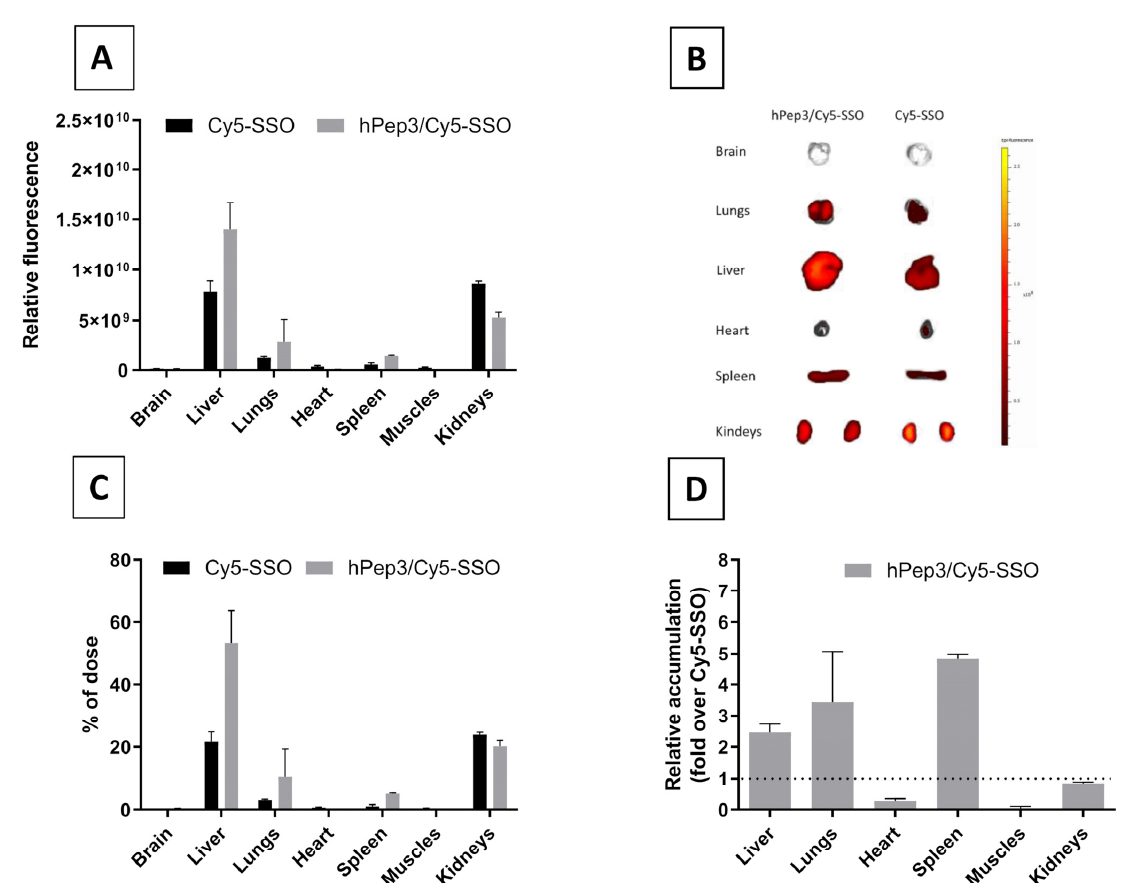
Figure 7. Biodistribution of hPep3/SSO nanoparticle formulation in vivo. ( A ) Biodistribution of hPep3/SSO nanoparticles in mice was evaluated upon intravenous injection of hPep3/Cy5-SSO nanoparticles or naked Cy5-SSO (at 2.5 mg/kg of SSO). 24 h after the injection, the tissues were harvested and the biodistribution evaluated by quantifying the total fluorescence with IVIS in vivo imager. ( B ) Representative IVIS images of the biodistribution of hPep3/Cy5-SSO and naked Cy5-SSO in different organs. ( C ) Percentage of the fluorescence signal from the total signal in different organs. ( D ) Relative increase in accumulation of the hPep3/Cy5-SSO nanoparticles compared to naked Cy5-SSO in different organs (presented as fold-increase over Cy5-SSO signal). N = 3.